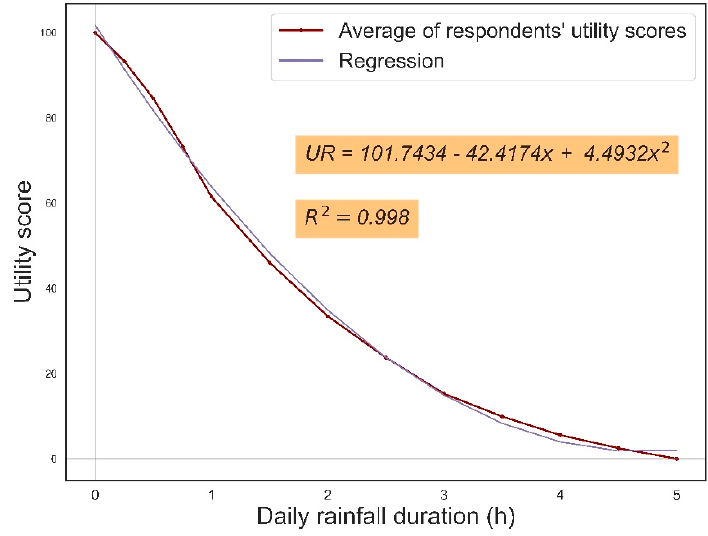
Figure 9. Empirical utility function for rainfall in urban tourism.